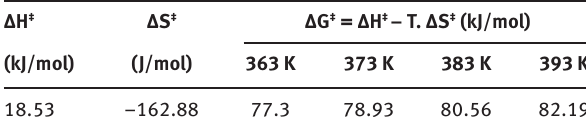
Table 2: Summary of thermodynamic activation parameters of styrene carbonate (SC) formation according to Eyring Equation.